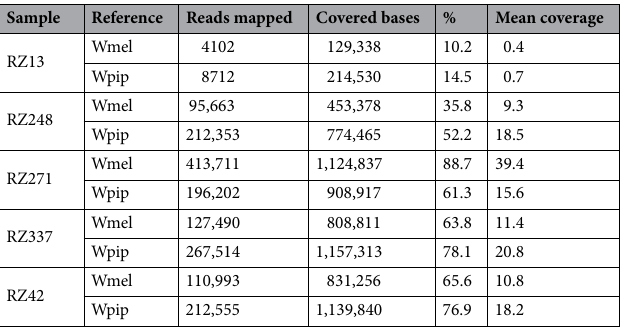
Table 2. Samples screened for Wolbachia genomes. The w Mel and w Pip are reference strains for the A- and B- Wolbachia supergroups, respectively. Covered bases column gives the length of the reference covered in bp. The column marked with % gives the percentage of the genome